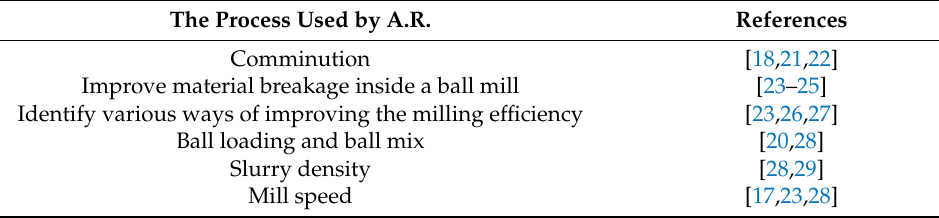
Table 2. Application of A.R. by different researchers in mineral processing. The Process Used by